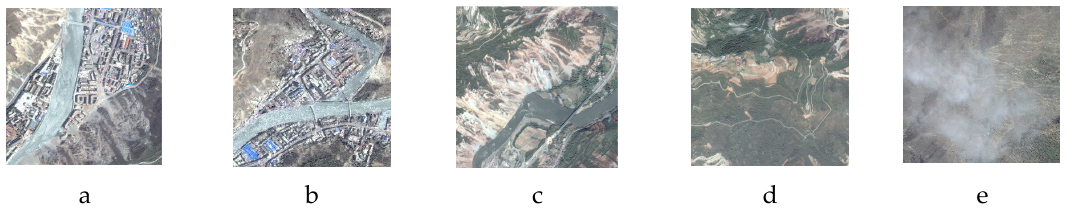
Figure 10. Images of the 5 scenes that include the main objects in our research, i.e., buildings, landslides and agriculture.